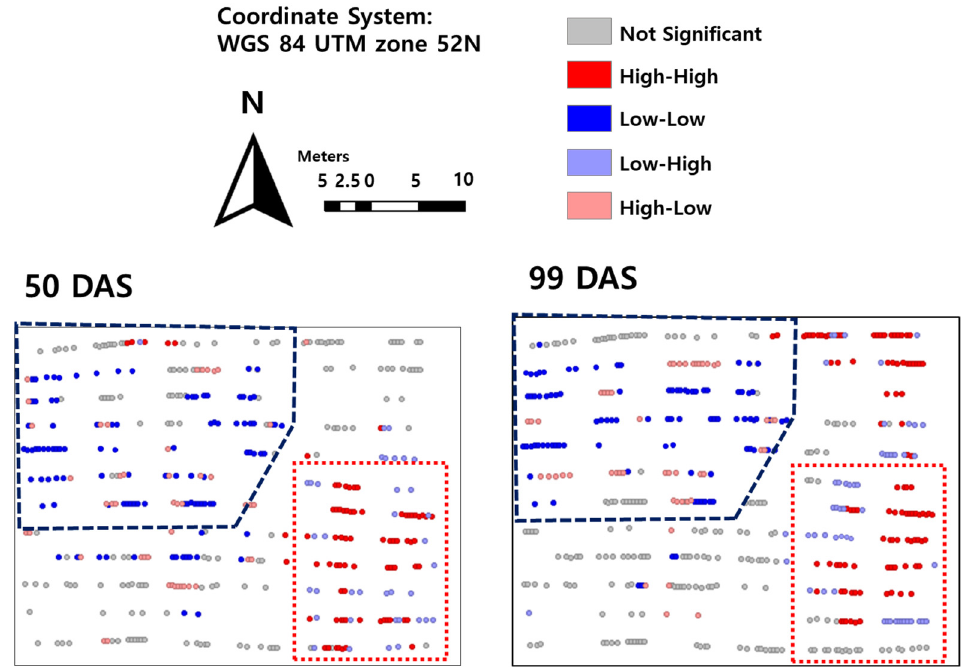
Figure 1. The Local indicators of Spatial autocorrelation cluster map (LISA) in 50 and 99 days after sowing. Blue dot and red dot are representative L-L and H-H, respectively. Moreover, blue dot polygon and the red dot polygon are indicated low-growth region and high-growth region, respectively.